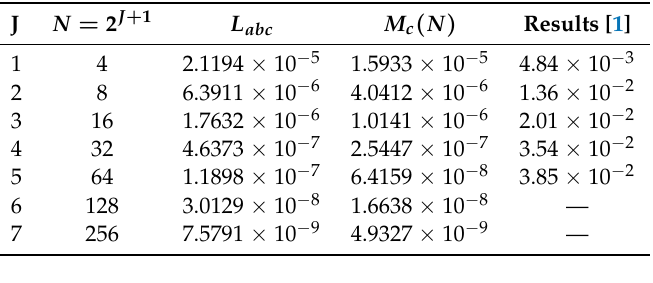
Table 1. L abc and M c ( N ) errors for Test Problem 1.